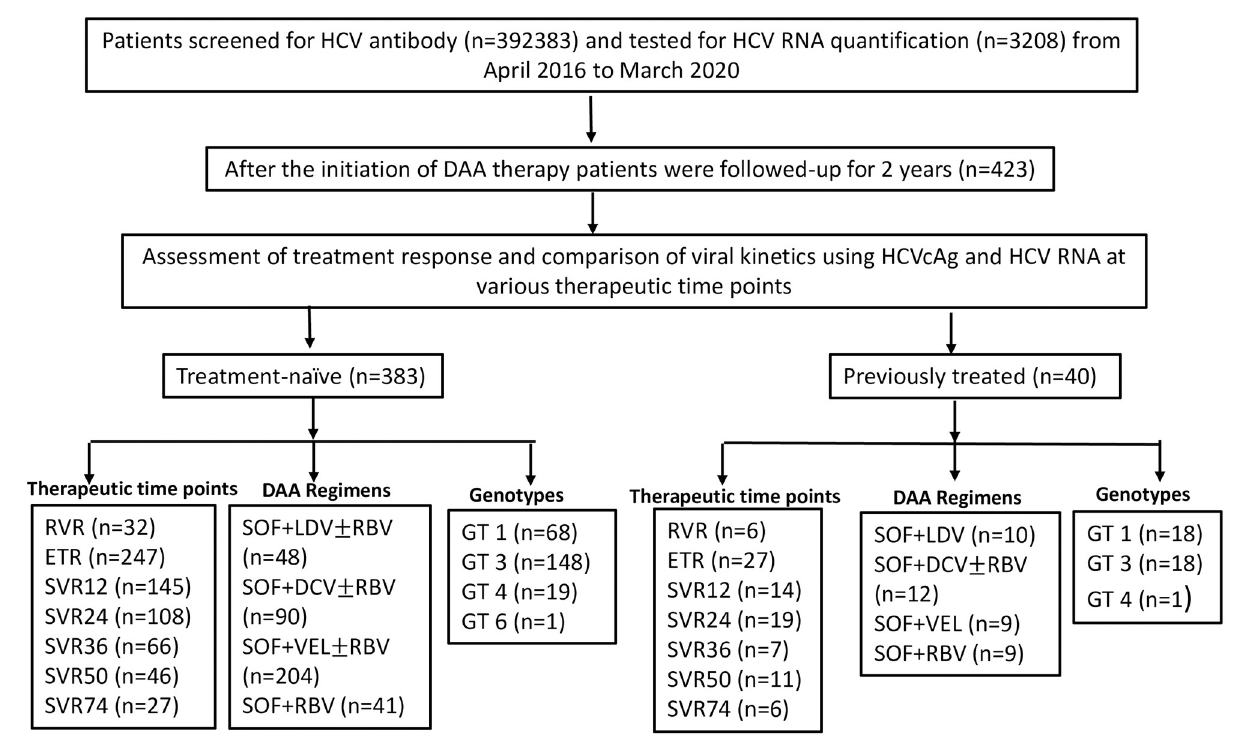
Fig 1. Flow chart of the study. Abbreviations: HCV, hepatitis C virus; RNA, ribonucleic acid; n, number; HCVcAg, hepatitis C virus core antigen; DAA, direct acting antiviral; RVR, rapid virological response; ETR, end of treatment response; SVR, sustained virological response; SOF, sofosbuvir; LDV, ledipasvir; DCV, daclatasvir; VEL, velpatasvir; RBV, ribavirin; GT, genotype.